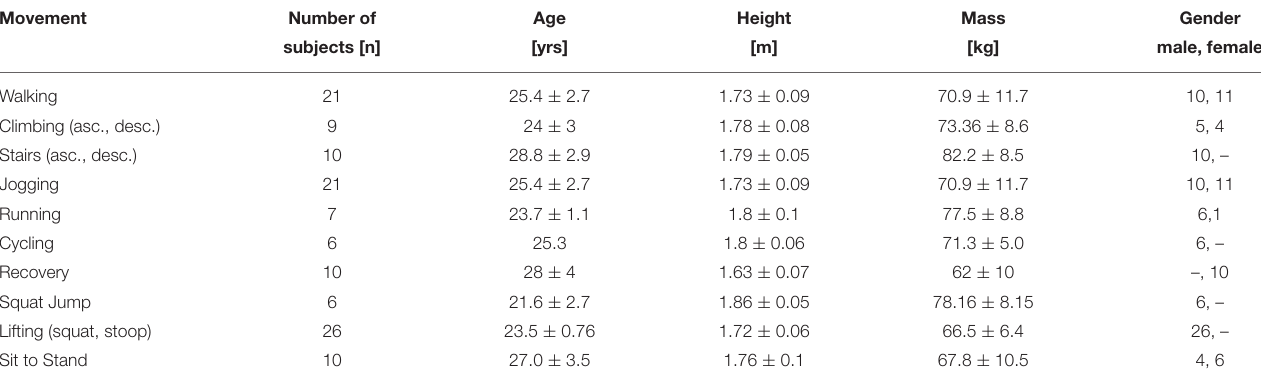
TABLE 2 | Subject characteristics for walking (Lipfert, 2010; Grimmer and Seyfarth, 2014), climbing (Lay et al., 2006), stair ambulation (Riener et al., 2002), jogging and running (Lipfert, 2010; Grimmer and Seyfarth, 2014), cycling (Ericson et al., 1986), recovery (Hsiao-Wecksler and Robinovitch, 2007), squat jump (Mackala et al., 2013), lifting (Hwang et al., 2009), and the sit to stand transition (Roebroeck et al., 1994). Movement